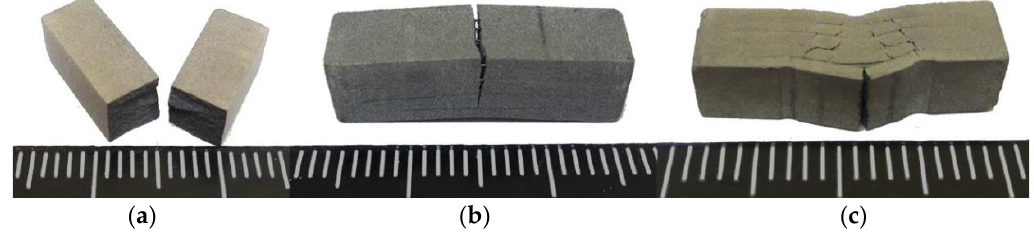
Figure 11. Specimens after bending tests: ( a ) without fibers, ( b ) with boron fibers, and ( c ) with tungsten fibers.